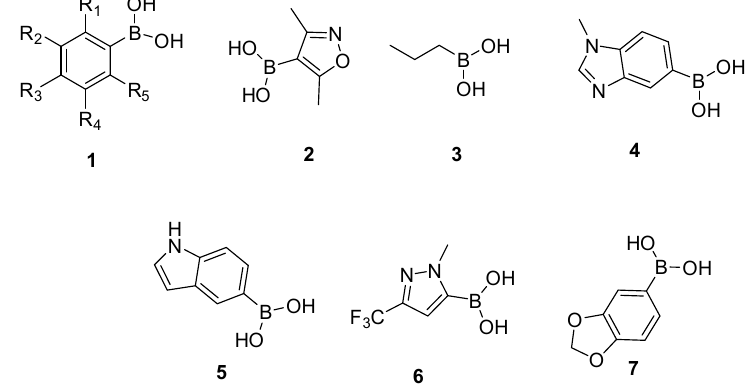
Figure 2. Boronic acid starting materials in this study.